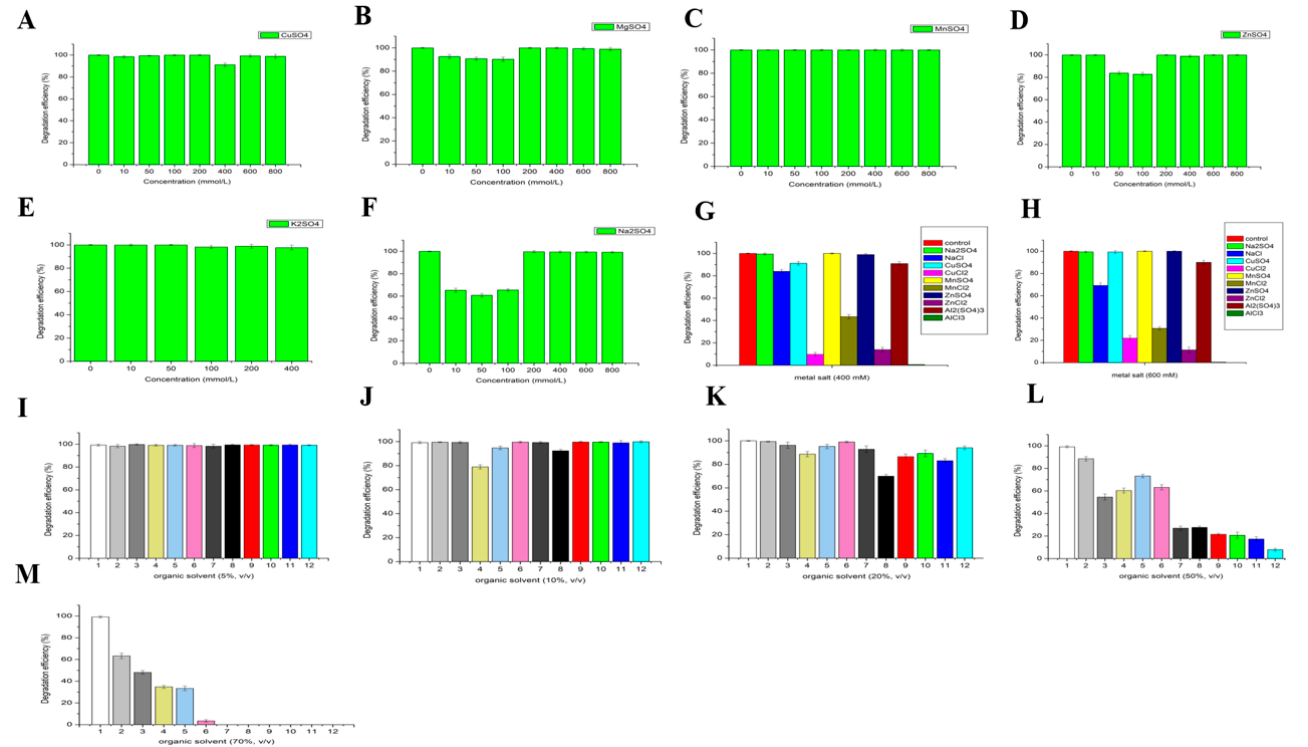
Figure 7. Effects of different concentrations of metal salts and organic solvents on the degradation of 2,6-DCP by LAC-4. ( A ) CuSO 4 ( B ) MgSO 4 ( C ) MnSO 4 ( D ) ZnSO 4 ( E ) K 2 SO 4 ( F ) Na 2 SO 4 ( G ) Comparison of the tolerance of LAC-4 for metal salts with sulfate as the anion and with chloride ions as the anion during the degradation of 2,6-DCP. The concentration of metal salt was 400 mM. Control, no addition of any metal salt. ( H ) Comparison of the tolerance of LAC-4 for metal salts with sulfate as the anion and with chloride ions as the anion during the degradation of 2,6-DCP. The concentration of metal salt was 600 mM. Control, no addition of any metal salt. ( I ) Concentration of the organic solvent was 5% ( v / v ). ( J ) Concentration of the organic solvent was 10% ( v / v ). ( K ) Concentration of the organic solvent was 20% ( v / v ). ( L ) Concentration of the organic solvent was 50% ( v / v ). ( M ) Concentration of the organic solvent was 70% ( v / v ). ( I – M ): 1: Control, no addition of any organic solvent. 2: Ethylene glycol; 3: Glycerol; 4: Butanediol; 5: Propylene glycol; 6: Methanol; 7: Ethanol; 8: DMF; 9: DMSO; 10: Acetone; 11: Isopropyl alcohol; 12: Acetonitrile.